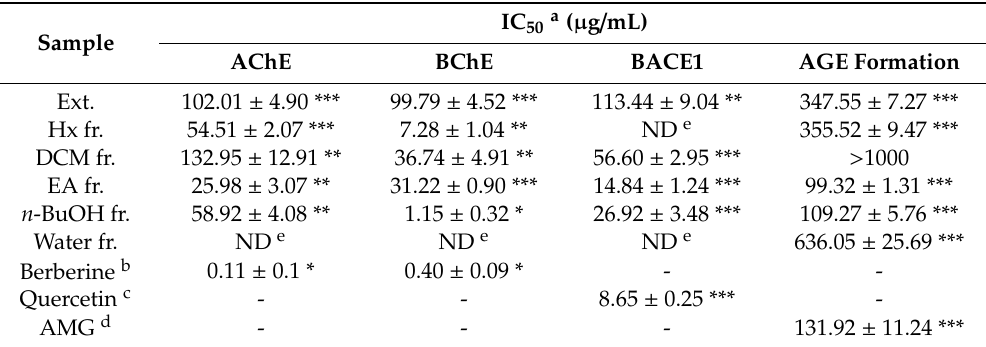
Table 3. IC 50 (inhibitory activity) of the H. di ff usa extract and fractions for cholinesterase (acetylcholinesterase (AChE) and butyrylcholinesterase (BChE)), β -site amyloid precursor protein cleaving enzyme 1 (BACE1), and the formation of advanced glycation end-product (AGE). IC 50 a ( µ g / mL) Sample AChE BChE BACE1 AGE Formation